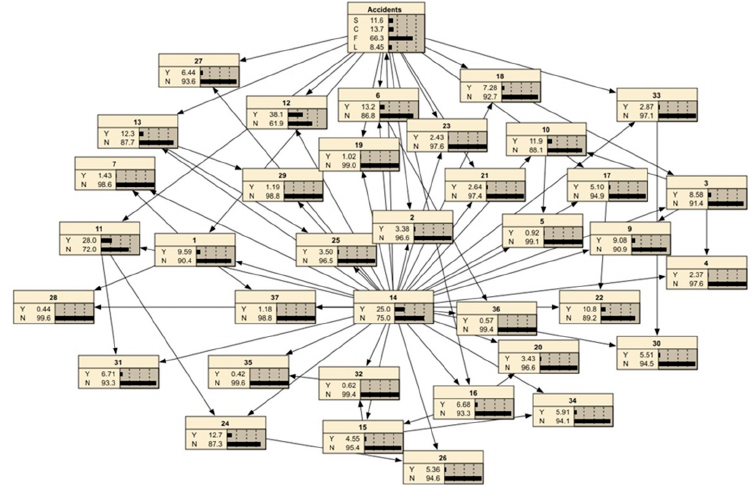
Figure 3. Bayesian network with no evidence.